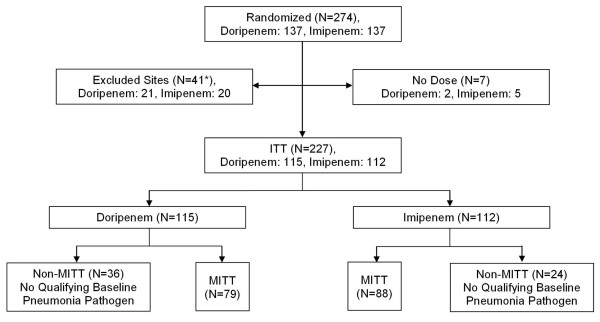
Patients enrolled and analyzed. ITT, intention-to-treat; MITT, Microbiological intention-to-treat. *Prior to study termination the Marketing Authorization Holder for the study identified five study sites (three in Guatemala, one in Germany, one in the United States), following independent internal reviews and re-monitoring by a contract research organization (CRO), that were found not to have adhered to the study protocols, or the study logs could not verify protocol adherence, and thus their data were excluded from the primary analyses.